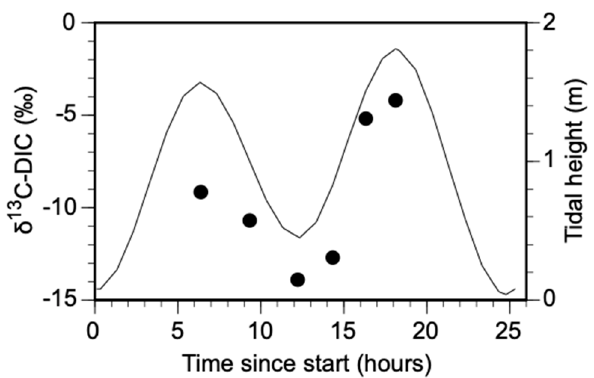
Figure 3. Variations of δ 13 C-DIC values at the river mouth during time course in winter. The line indicates the tidal height (m) obtained from the Japan Meteorological Agency (JMA).